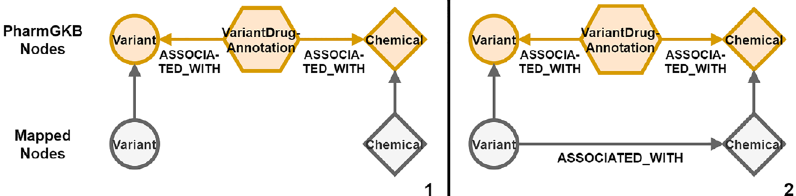
Figure 7: Path mapping of three data source nodes and two edges. (1) Two nodes variant and chemical in orange from the same data source are both associated with a VariantDrugAnnotation node. They both are connected to their respective mapping node in grey. The path of length two is matched and provided to the path mapping. (2) A new edge with the mapped label from the ASSOCIATED_WITH edges is created between the mapping